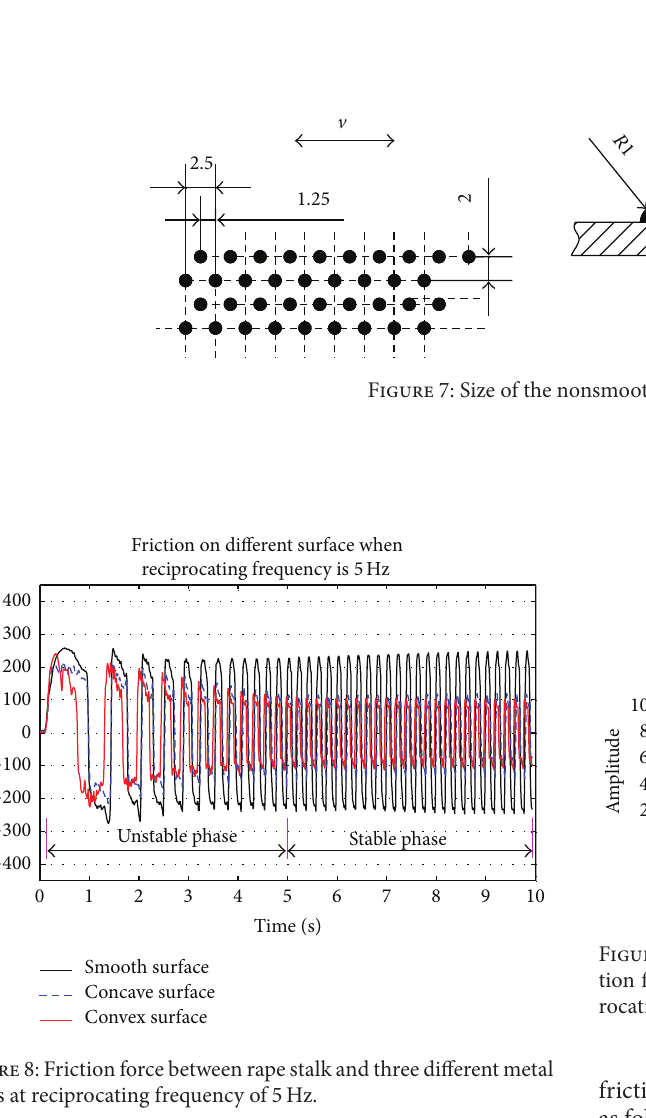
Figure 6: Photograph of three different rectangular plates with (a) smooth, (b) convex, and (c) concave surfaces.